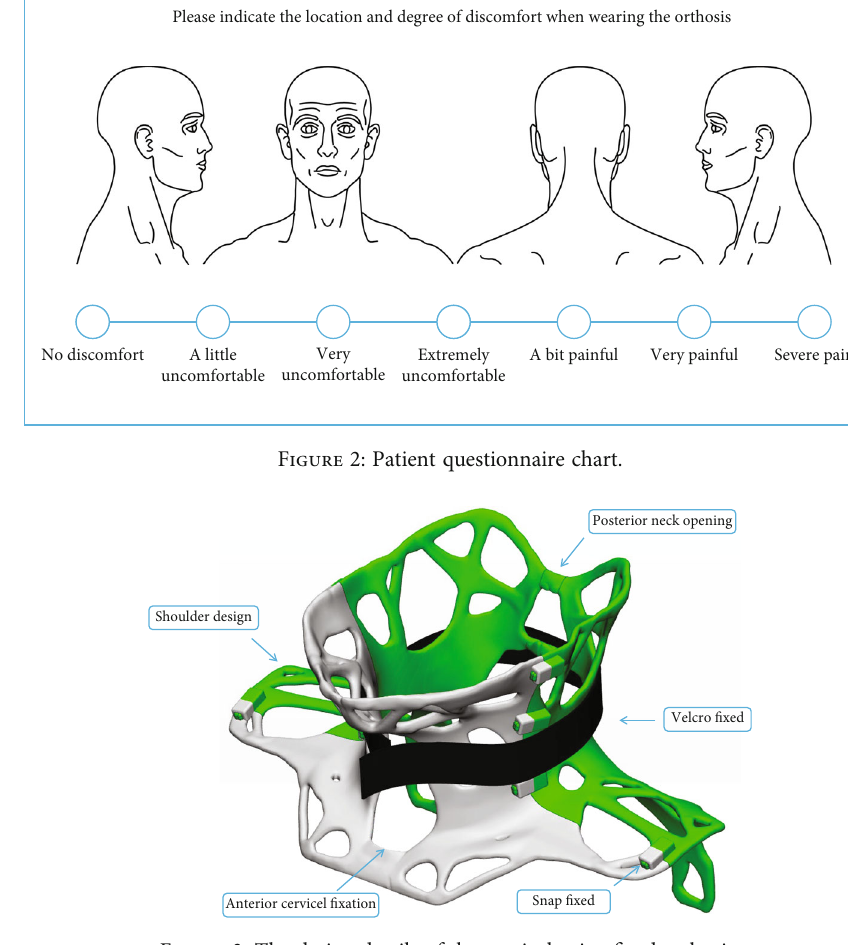
Figure 3: The design details of the cervical spine fi xed